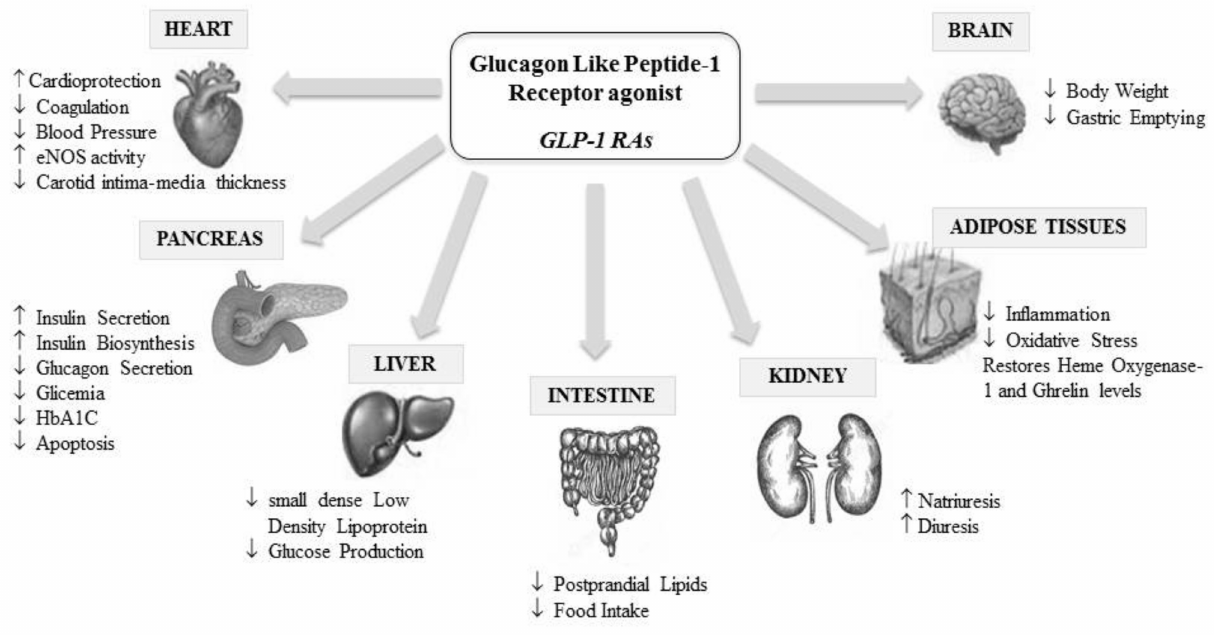
Figure 4. Glucagon-like peptide-1 receptor agonist (GLP-1RAs) pleiotropic